Question: Give a one-sentence summary of this figure.
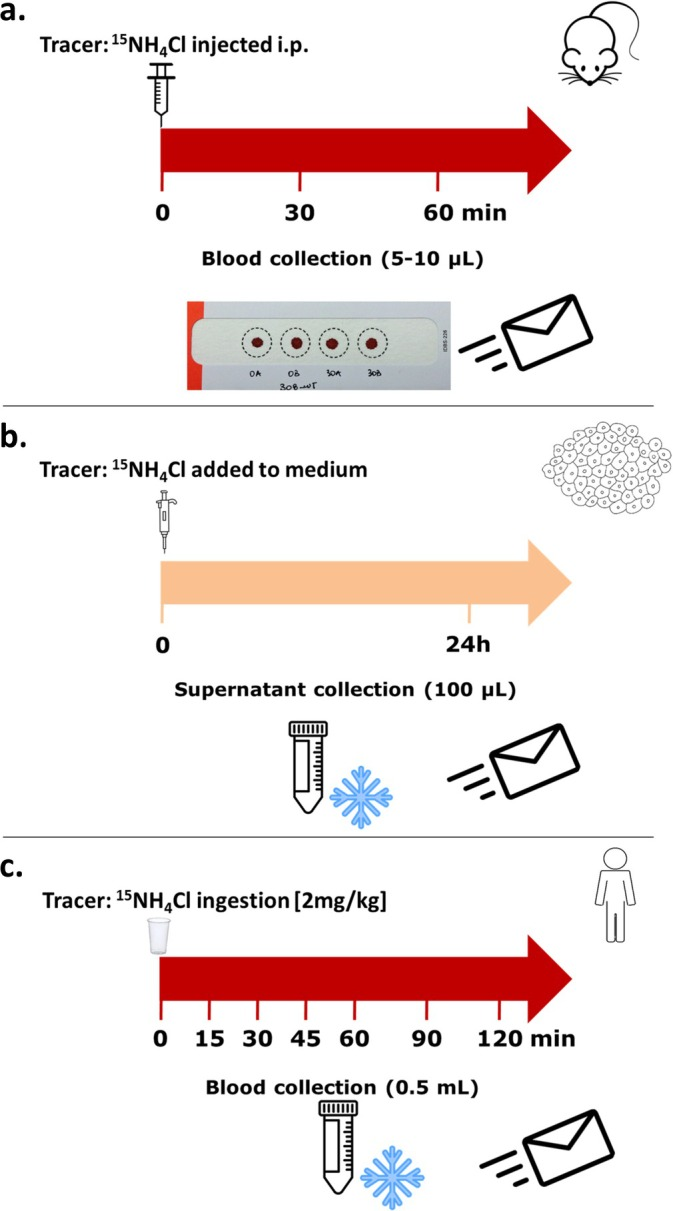
Answer: The figure shows in a simplified way the practical aspects of the ureagenesis assay when performed in mice (a) or cells (b); for comparison, the assay procedure is also shown for humans (c, modified from b, in [ 12 ]). ip, intraperitoneal.